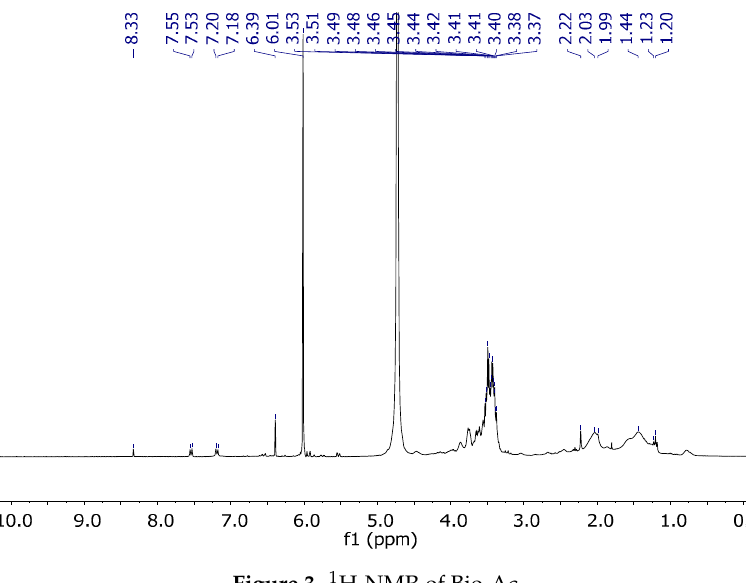
Figure 3. 1 H-NMR of Bio-Ac.